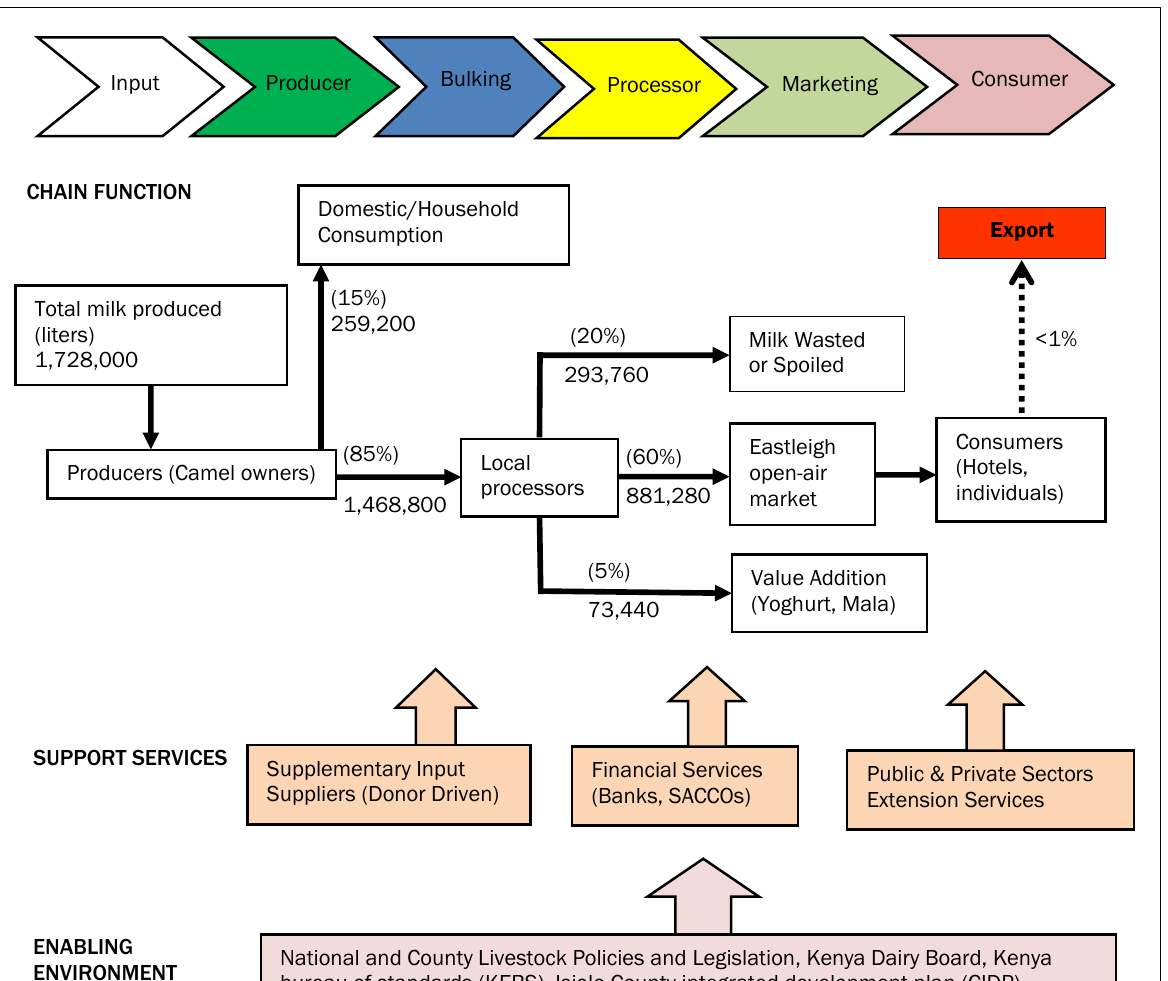
Figure 2. A Schematic Presentation of the Analysis of a Typical Camel Milk Value Chain in Isiolo County, Northern